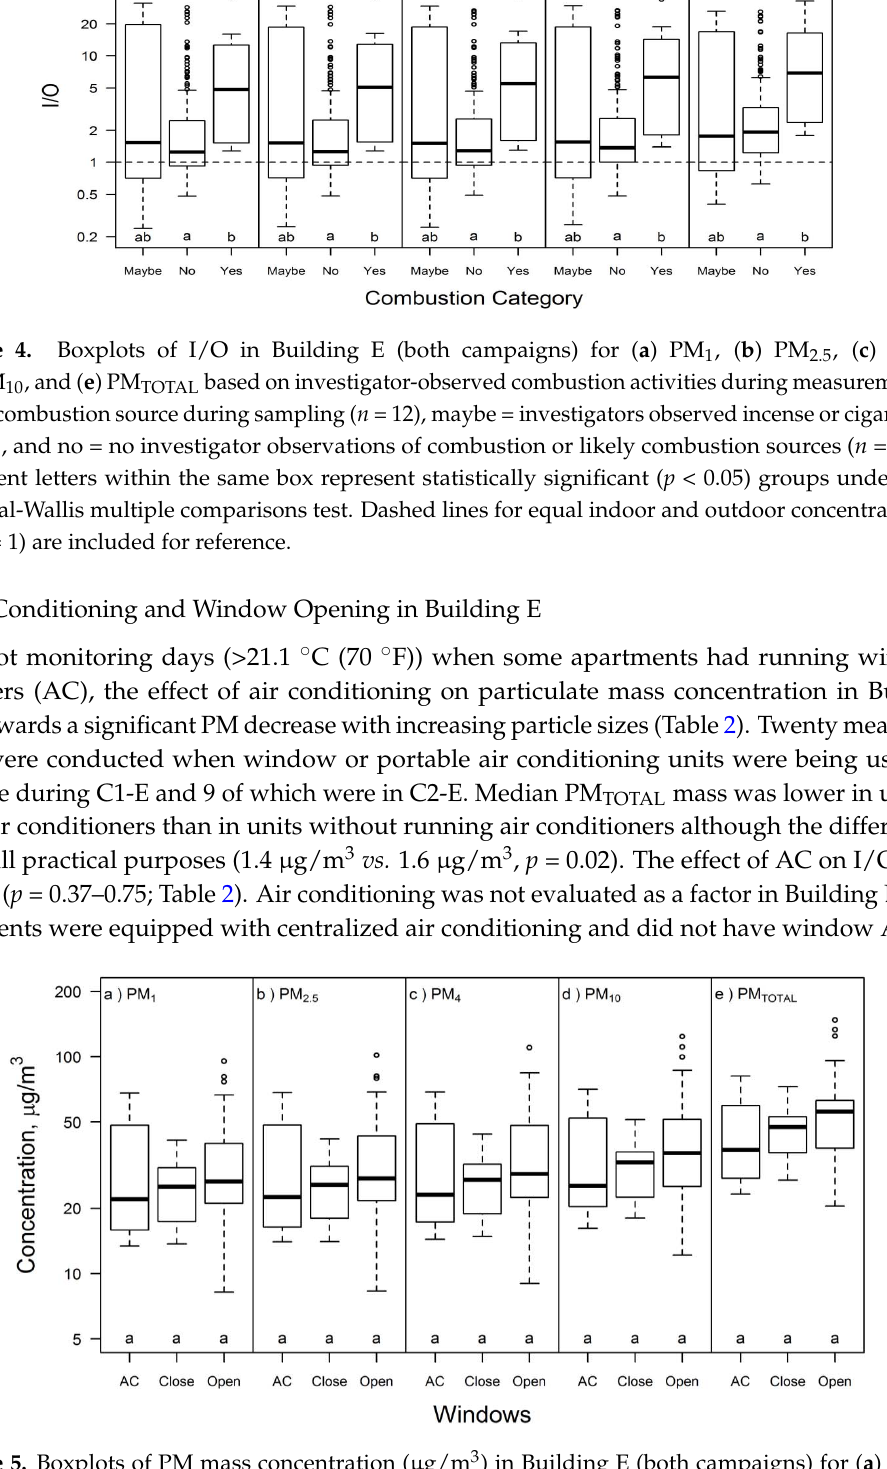
Figure 3. Airborne PM mass concentration ( μ g/m 3 ) in Building E (both campaigns) for ( a ) PM 1 ; ( b ) PM 2.5 , ( c ) PM 4 ; ( d ) PM 10 ; and ( e ) PM TOTAL based on investigator ‐ observed combustion activities during measurements: yes = combustion source during sampling ( n = 12), maybe = investigators observed incense or cigarettes ( n = 8), and no = no investigator observations of combustion or likely combustion sources ( n = 203). Different letters within the same box represent statistically significant ( p < 0.05) groups under the Kruskal ‐ Wallis multiple comparisons test.